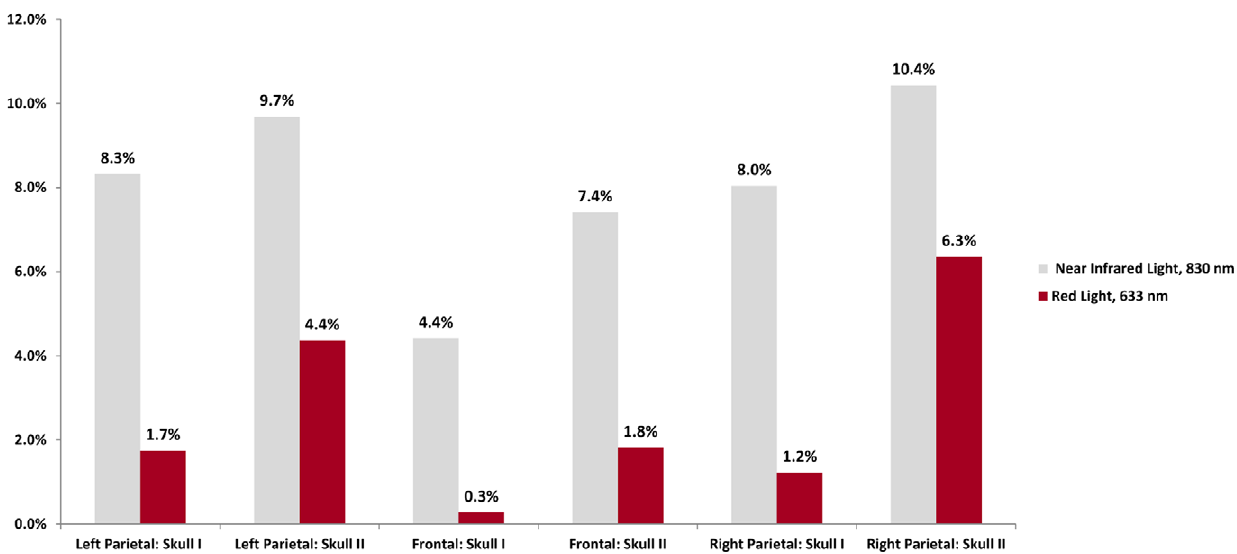
Figure 2. Percent Penetrance of Light through Coronal Sections of Cadaver Skull, Bone Only. Near infrared light measurably penetrates cadaver skull, as compared to red light.